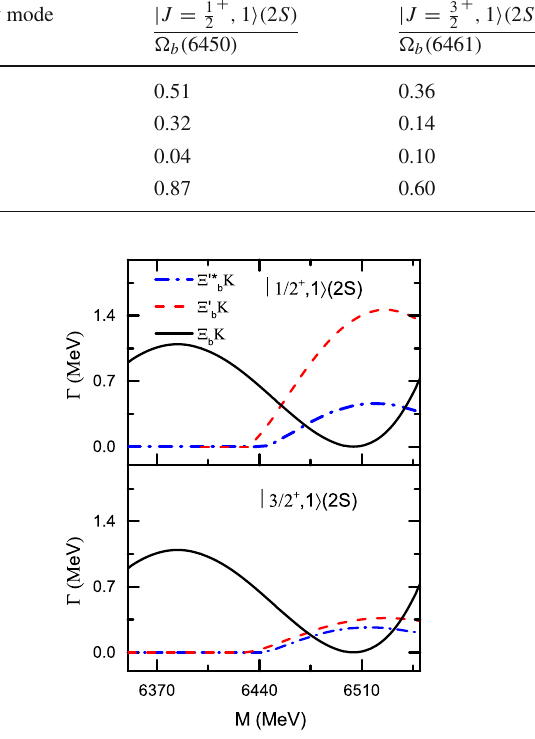
Fig. 3 Partial decay widths of the 2 S states with J P = 1 / 2 + and J P = 3 / 2 + , respectively, as a function of the masses